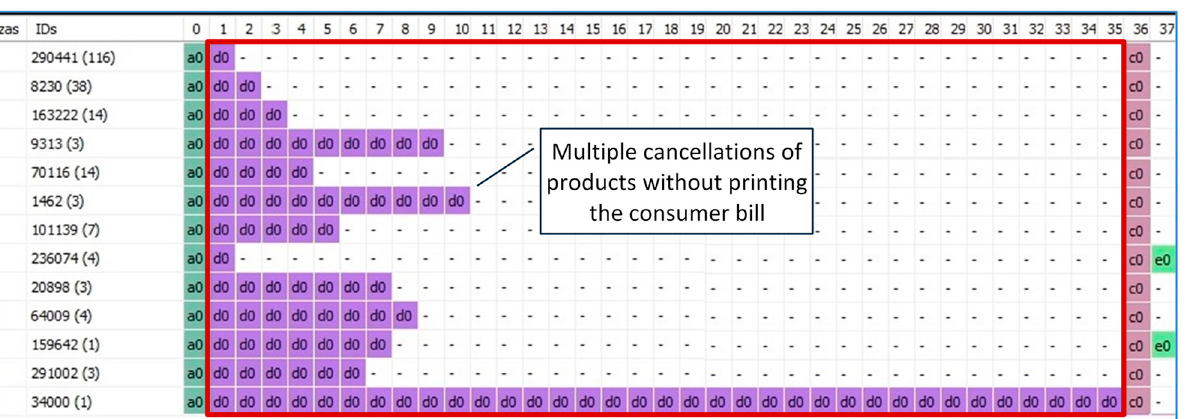
Figure 14. Sequences with product eliminations without the printing of the check.  Comparison of sequences with suppressed products depending on the means of pay ‐ ment.